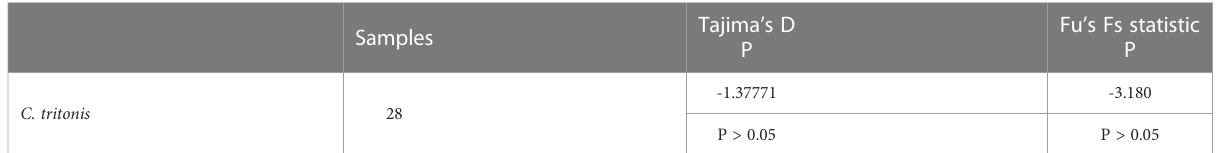
TABLE 6 Tajima ’ s D and Fu ’ s F statistic among C. tritonis .